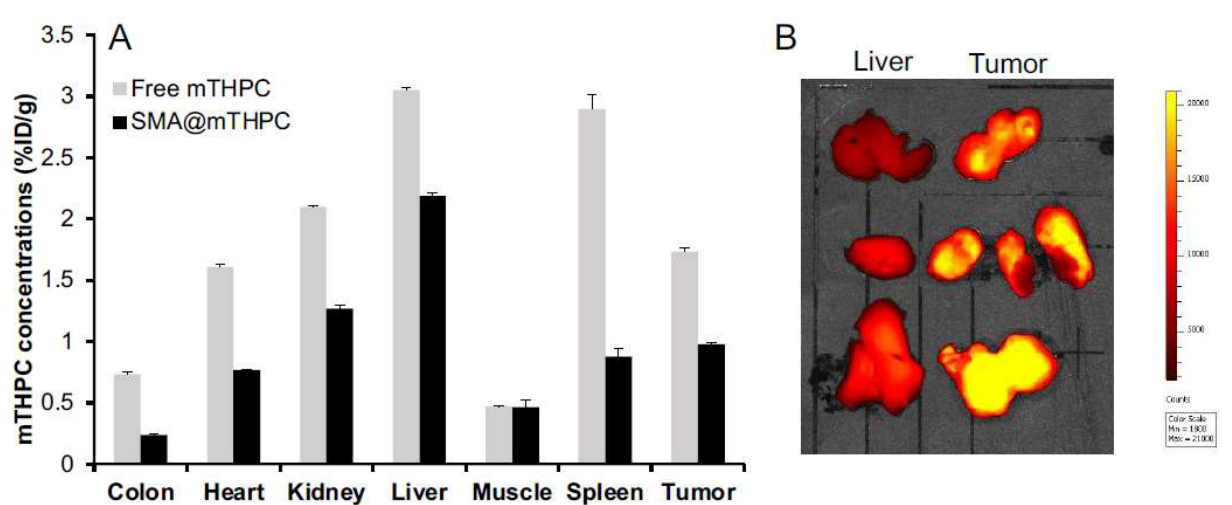
Figure 7. In vivo tissue distribution of SMA@mTHPC at 24 h after i.v. injection in sarcoma S180 tumor-bearing mice. In the S180 solid tumor model, SMA@mTHPC (5 mg/kg mTHPC equivalent) or free mTHPC (5 mg/kg) was i.v. injected when the tumor grew to the size of about 10 mm in diameter; the mice were then killed and indicated tissues were collected, and the amount of SMA@mTHPC in each tissue was quantified by detecting the fluorescence of mTHPC ( A ). In a separate experiment, the tumor and liver of SMA@mTHPC-treated mice were resected and applied to in vivo imaging using IVIS ( B ). See text for details. Data are mean ± SD, n = 3–6.